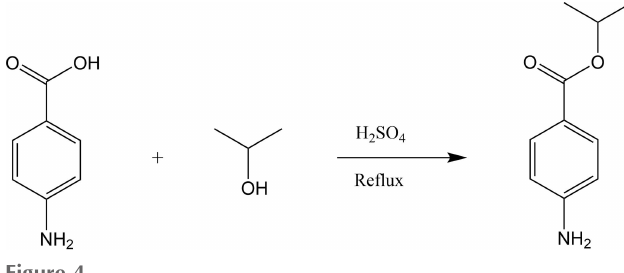
Figure 4 Reaction